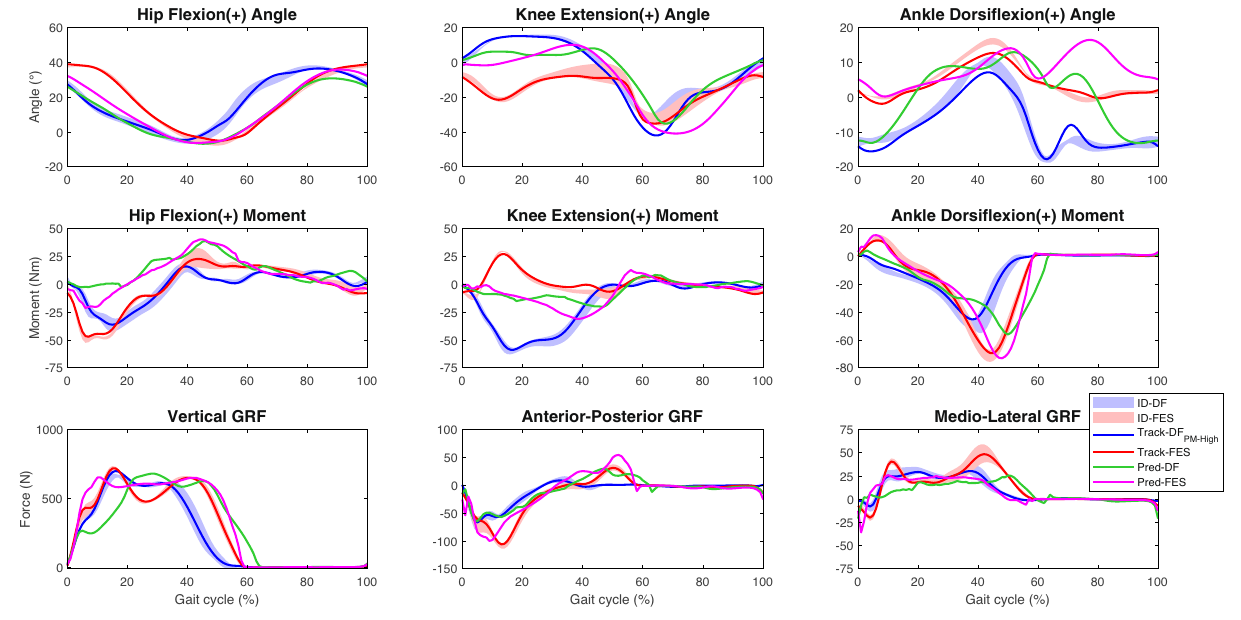
Figure 4. Effect of FES on ID (mean ± standard deviation), tracking, and prediction DF gait (ipsilateral hip, knee, and ankle angles, moments, and GRF). Contralateral results are presented in Supplementary Fig.